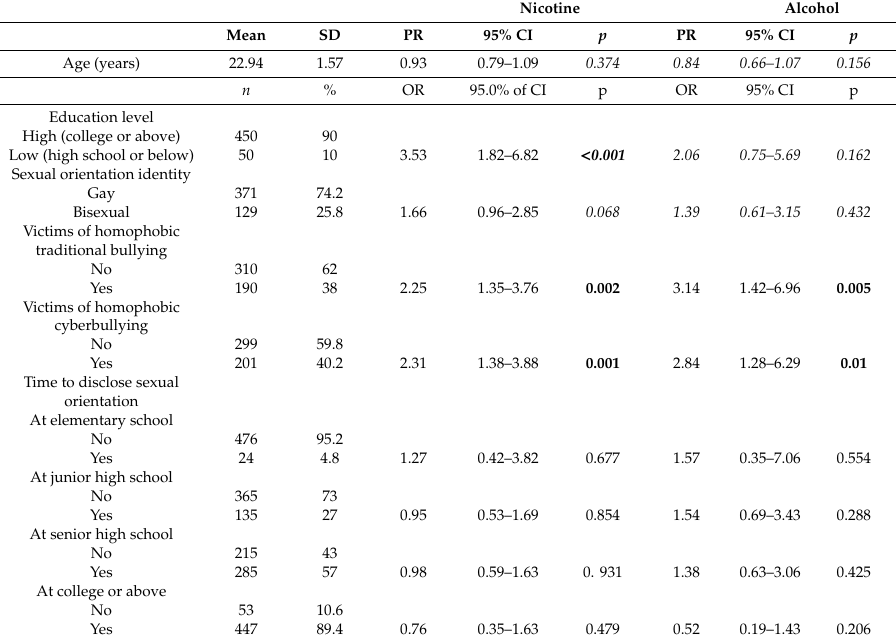
Table 4. Associations of demographic factors, sexual orientation and victimization of homophobic bullying with nicotine and unhealthy alcohol use examined by univariate logistic regression ( n =